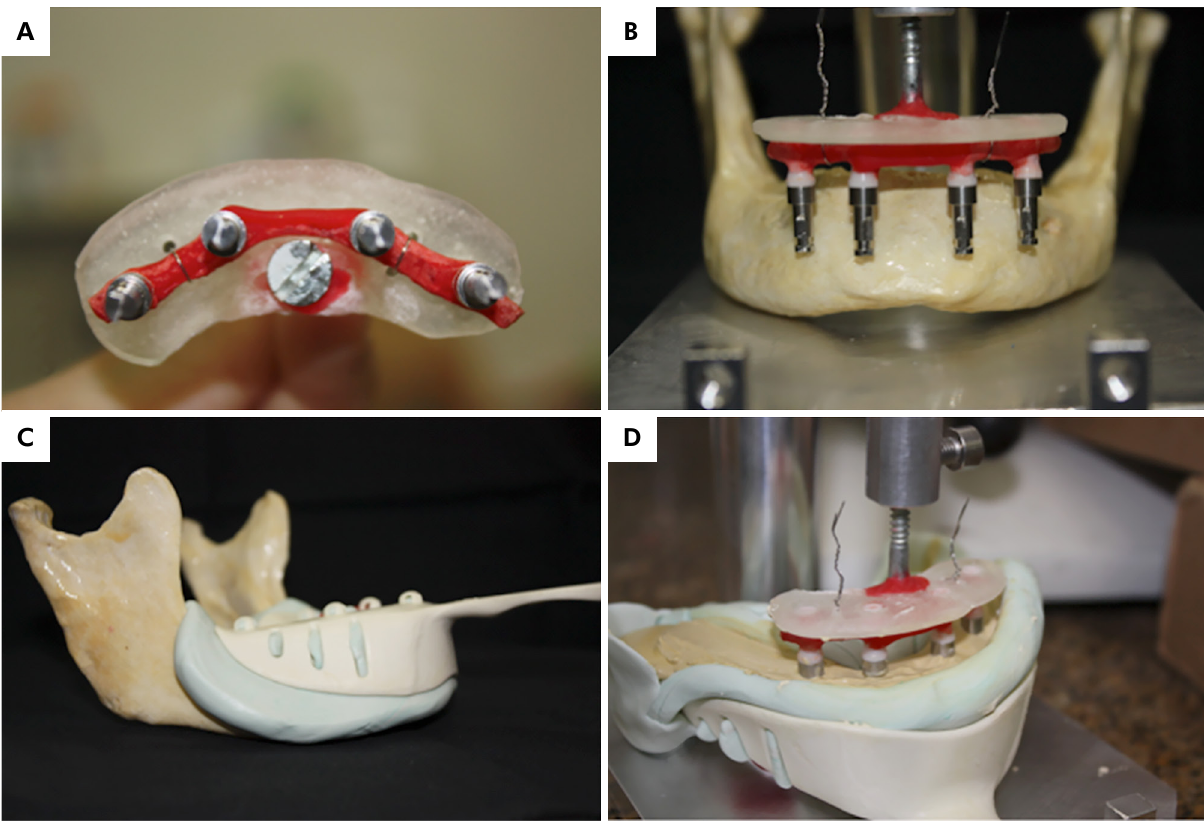
Figure 2. Sequence to bar confection: A) Jaw shaped B) Analogue distribution C) Bone impression D) Plaster cure.